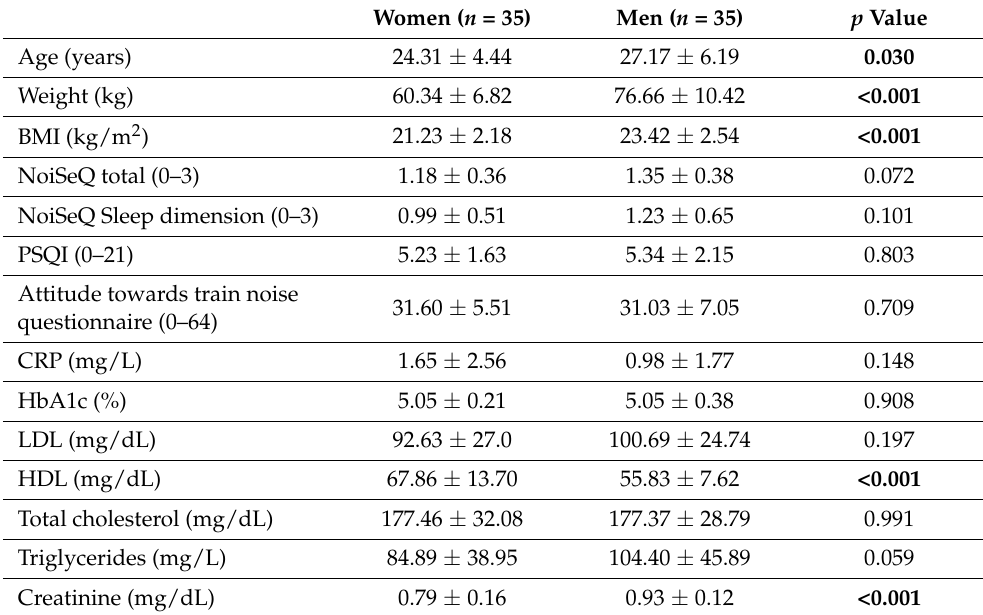
Table 1. Baseline/screening characteristics of the study sample stratified by sex (N =